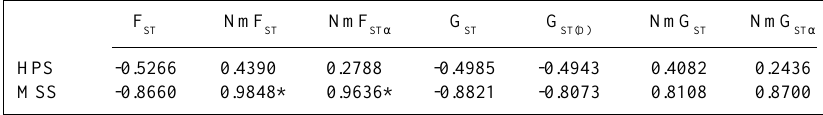
Table III - Correlation matrix (r) between gene differentiation and gene flow statistics of four cat populations at a subpopulation level with two demographic parameters, human population size (HPS) and median sample size (MSS). F (wright genetic differentiation statistic), NmF (gene flow from ST ST the F statistic in an infinite island model), NmF (gene flow from the F statistic in an n- ST ST a ST dimensional island model), G (average Nei genic differentiation statistic), G (direct Nei genic ST ST(D) differentation statistic), NmG (gene flow from the G statistic in an infinite island model), NmG ST ST ST a (gene flow from the G statistic in an n-dimensional island ST